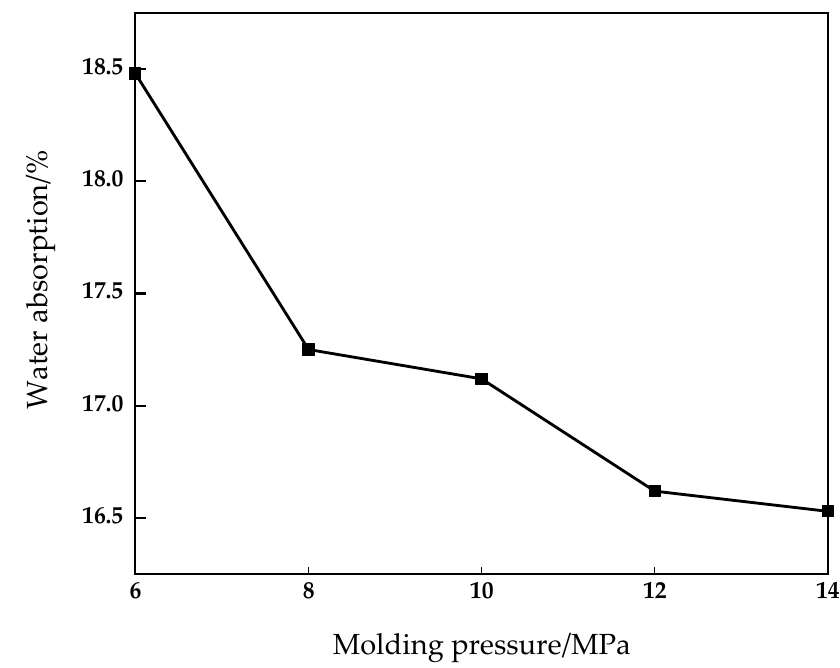
Figure 8. Effect of molding pressure on water absorption of fired brick.